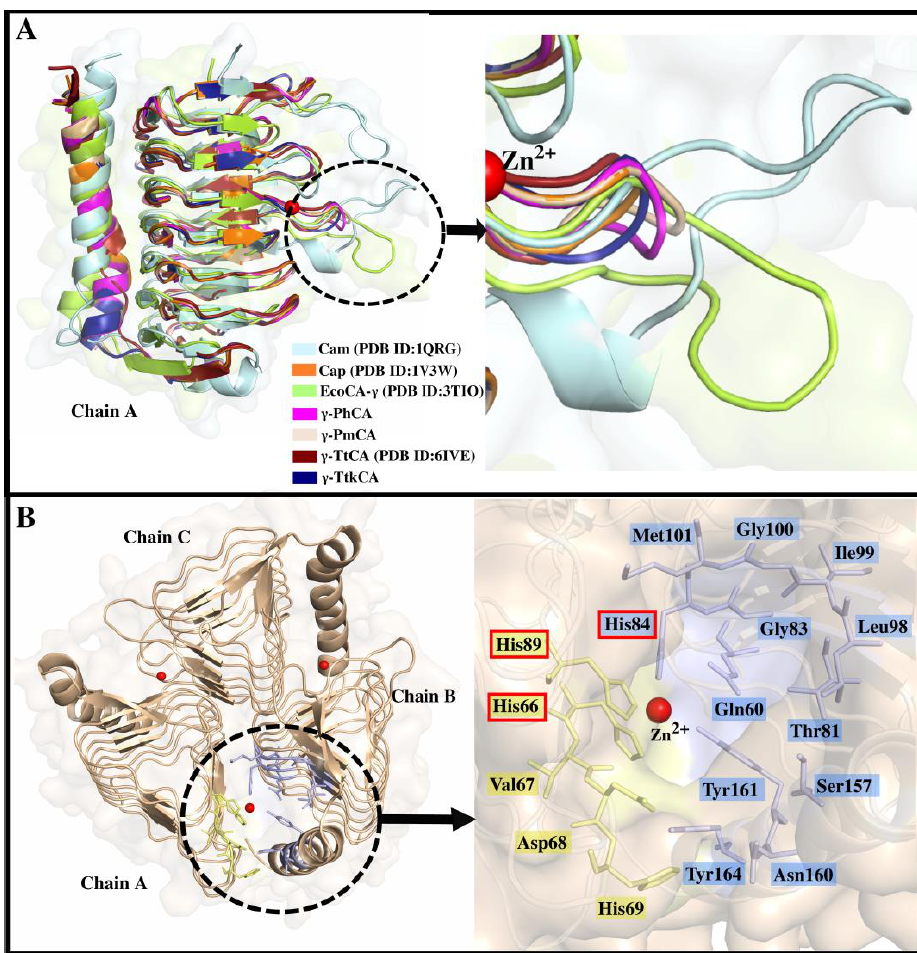
Figure 2. ( A ): Aligned monomeric γ -CA structures of Cam (cyan), Cap (orange), EcoCA- γ (green), γ -PhCA (magenta), γ -PmCA (wheat), γ -TtCA (maroon), and γ -TtkCA (dark blue). The loop region indicated in the MSA is shown by the black dotted circle and zoomed into in the image pointed to by the black arrow. ( B ): Trimeric structure of γ -PmCA with the active site which is located between Chains A and B delimited by the black dotted circle. The black arrow points to the enlarged active site showing the residues that contribute to its formation. Zn 2+ is shown as a red sphere and the three His residues coordinating it are boxed in red.